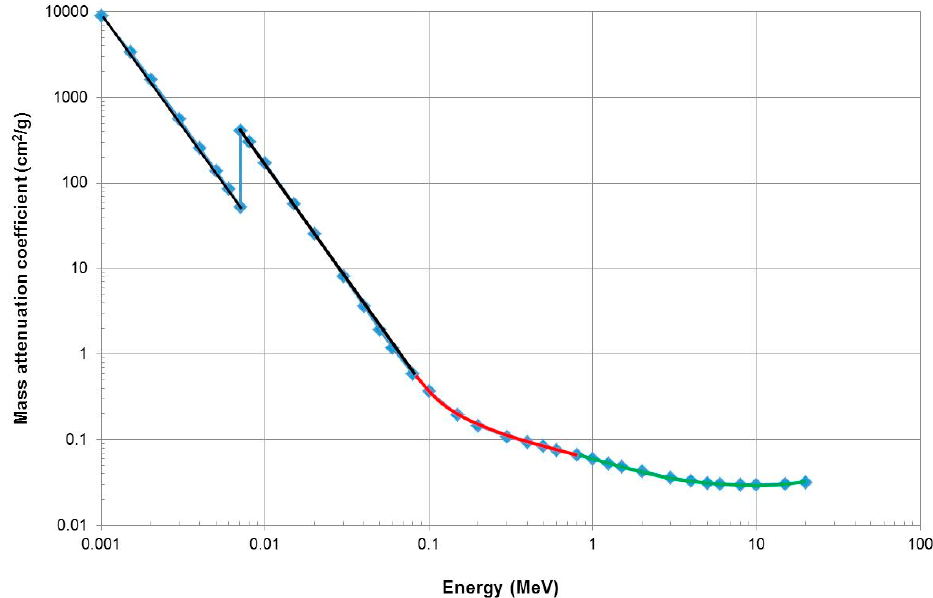
Figure 3. The representation of iron mass attenuation coefficient by different equations (linear, second and fifth order polynomial). The black lines represent linear equations (Equation (1)) and the red and green curves represent the second and fifth order polynomial equations (Equations (2 and 3)).